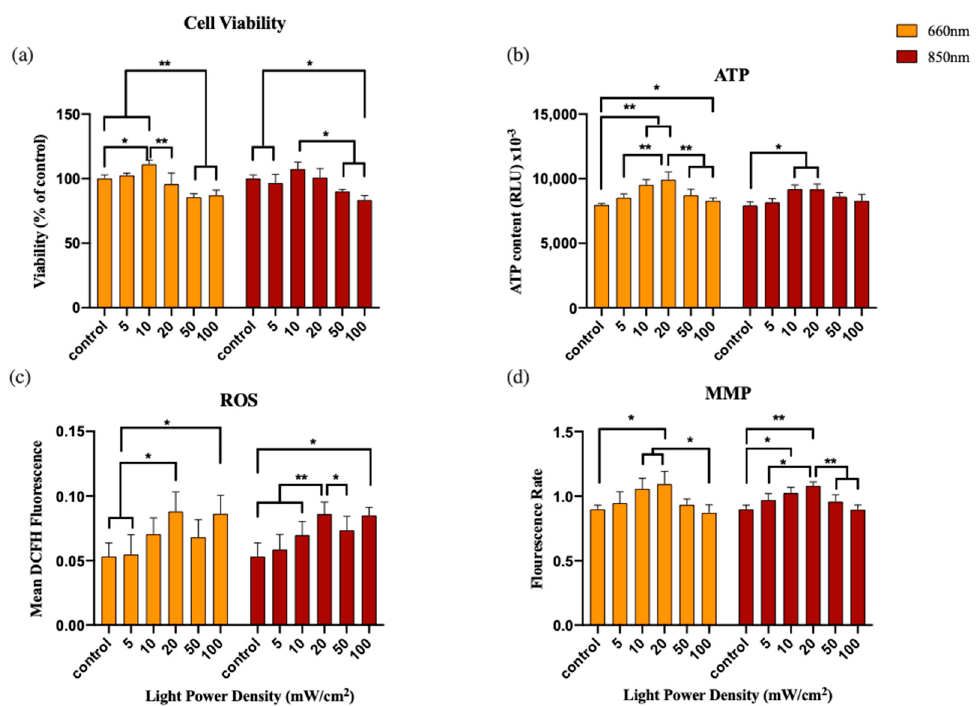
Figure 4. Comparison between control and CW light with different power densities: ( a ) cell Viability, ( b ) ATP, ( c ) ROS, and ( d ) MMP. * p < 0.05 and ** p < 0.01.